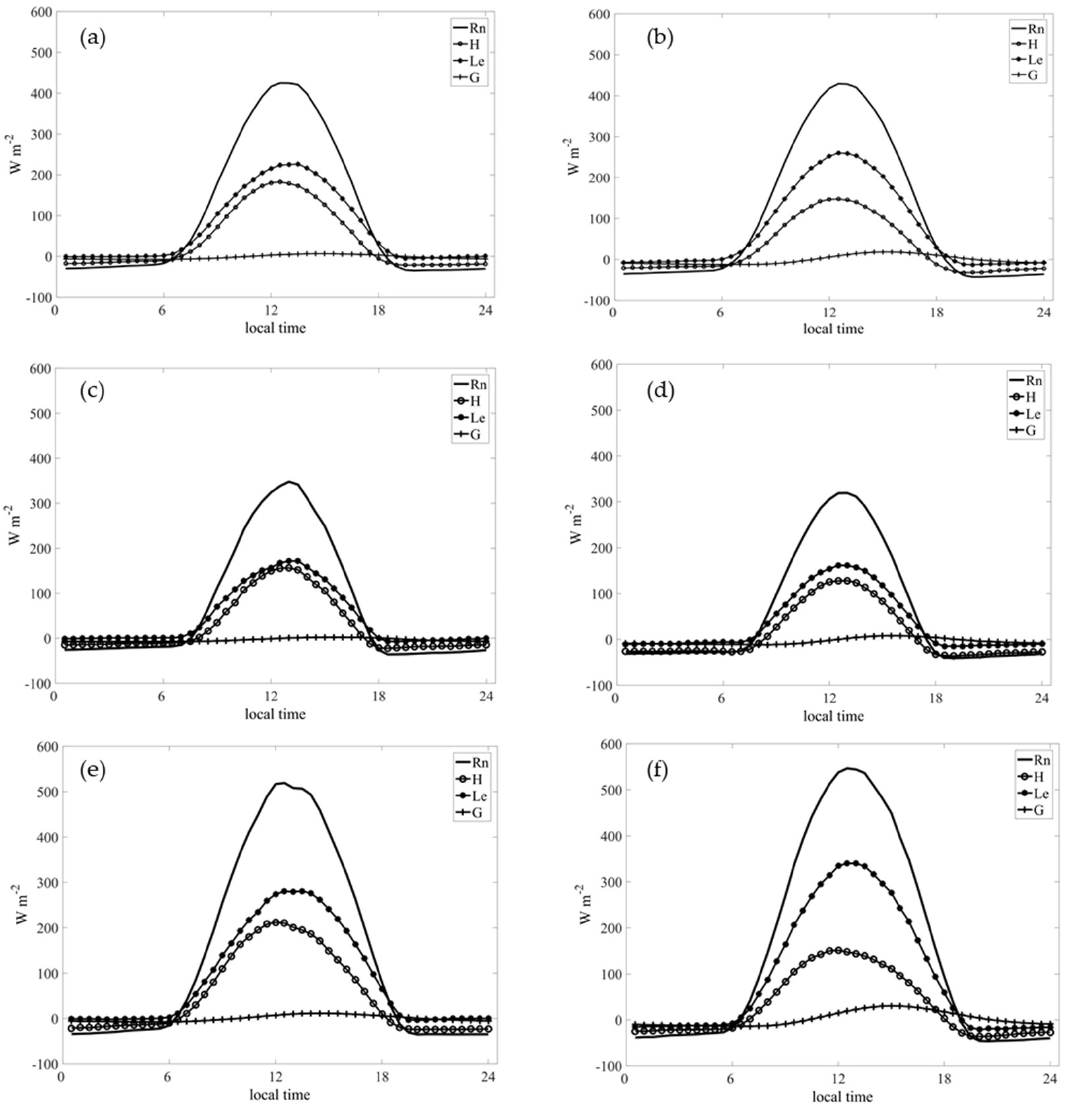
Figure 5. Daily cycle of the energy balance components, Rn (W m − 2 ); H (W m − 2 ); LE (W m − 2 ); G (W m − 2 ) for the SMA site on the left column and PAS on the right. ( a , b ) Average for the entire period; ( c , d ) AW; ( e , f ) SS.